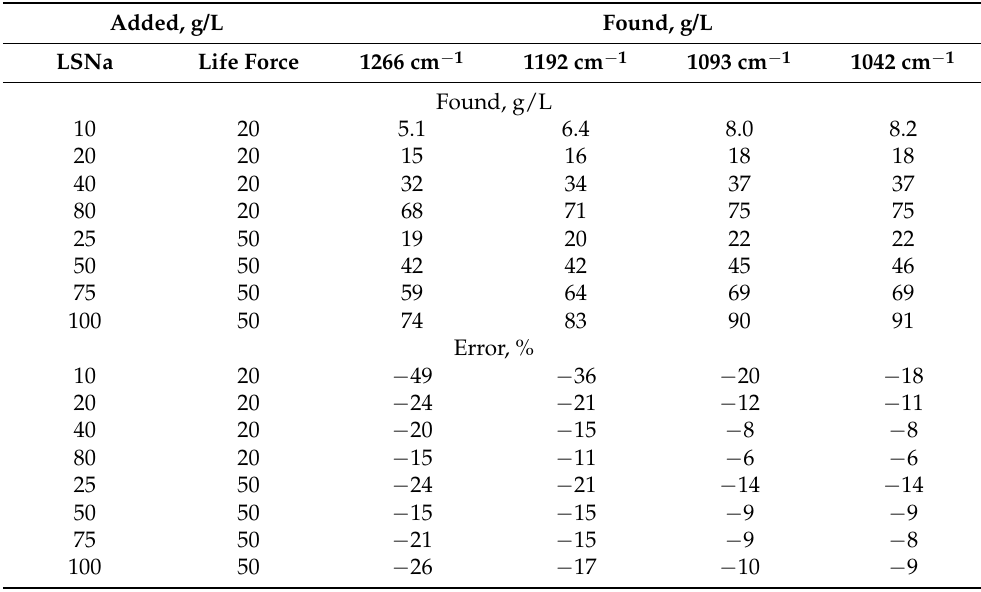
Table 5. Concentrations and errors of lignosulfonate quantification in mixtures with Life Force humate using a calibration by Powhumus at different bands ( n = 6, p =